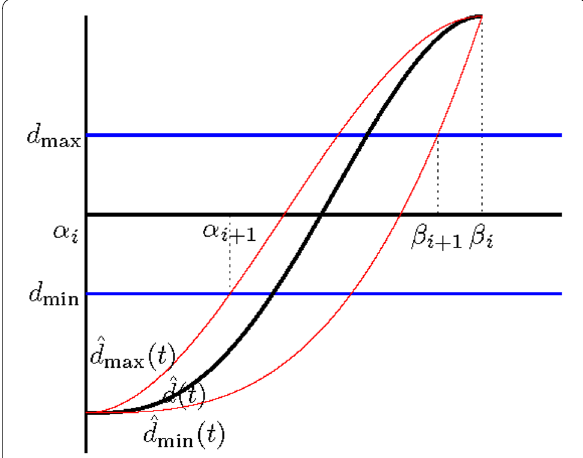
Fig. 3 Clipping computed